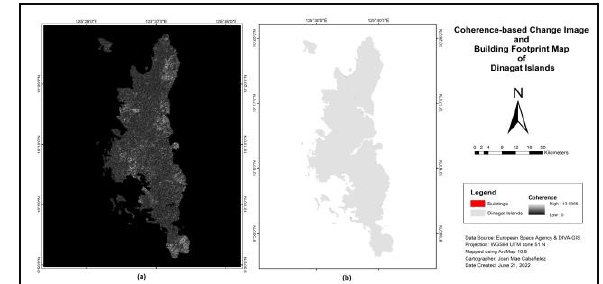
Figure 8 . Coherence-based change image and building footprint of Dinagat